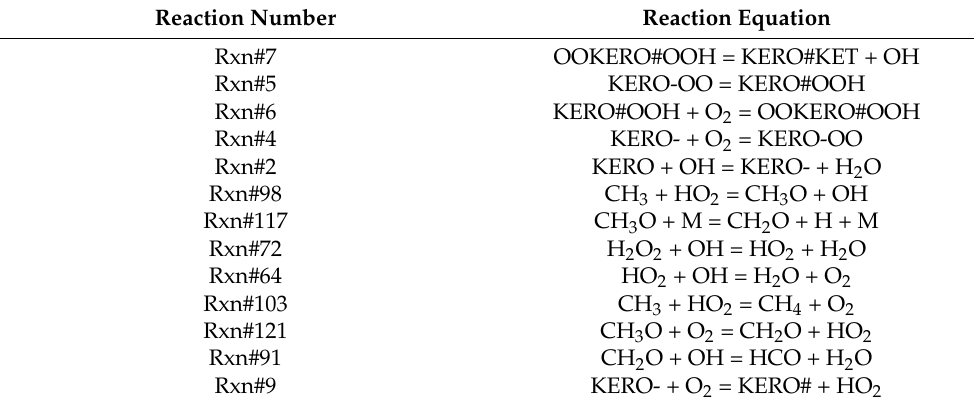
Table 3. Lists of the important reactions of kerosene.